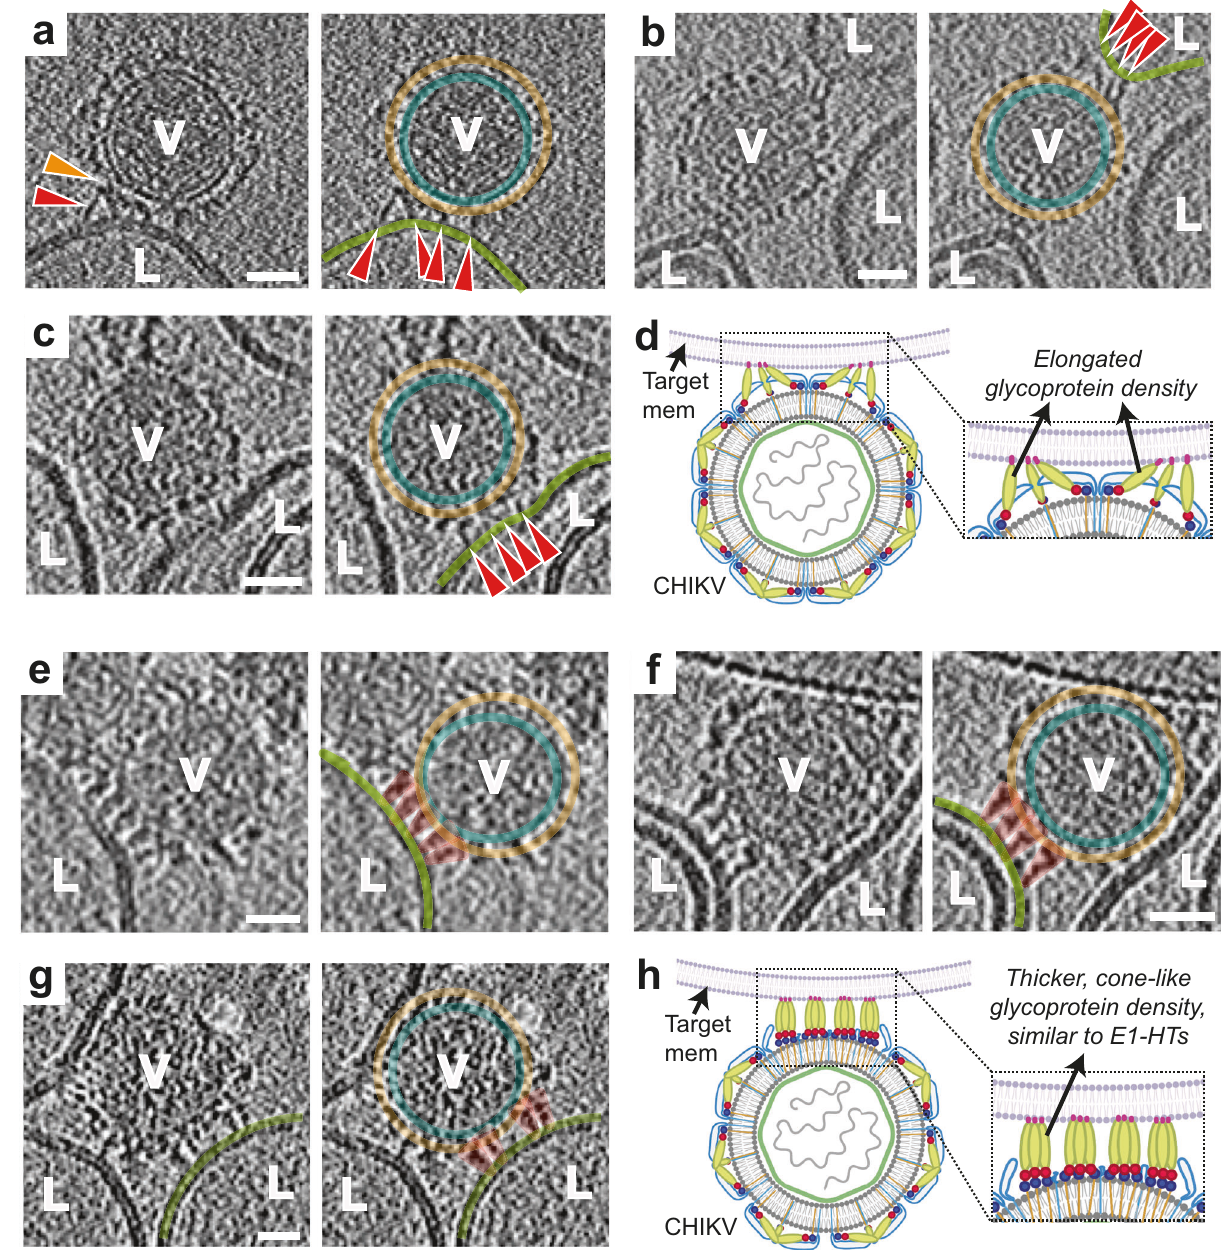
Fig. 3 | Glycoprotein membrane attachment and E1 homotrimer formation (stages II and III). a – c Stage II. Left panels: Tomogram slice showing long bridge- like attachments between CHIKV (V) and liposomes (L). Red arrowhead indicates extended glycoprotein density and orange arrowhead denotes remaining glyco- proteindensityclosetotheviralmembranesurface.Right:Sametomogramsliceas intheleftpanelsbutannotatedtoshowthedifferentproteinandmembranelayers. CHIKV glycoprotein layer in orange, CHIKV membrane in teal and liposome membrane in green. Glycoprotein attachments between CHIKV and liposome